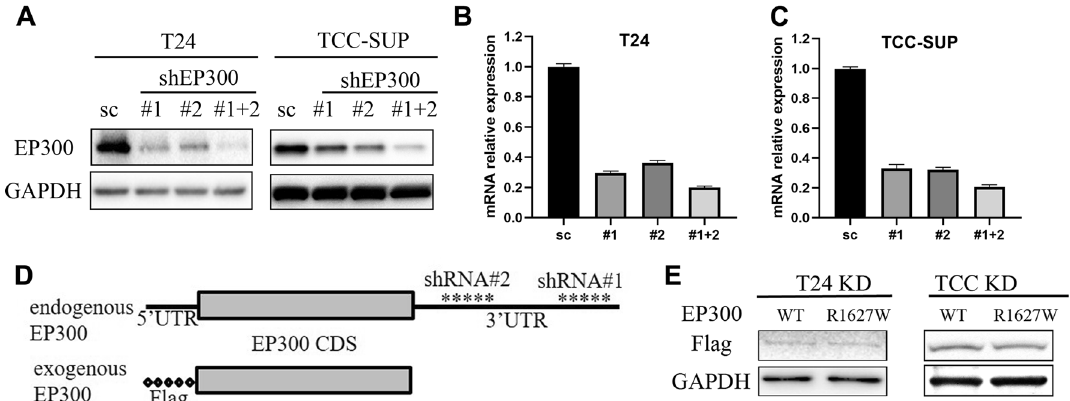
Fig. 2 Establishment of EP300 knockdown bladder cancer cell lines. A EP300 protein level in T24 and TCC-SUP cell lines after transfection of EP300 shRNAs. B, C EP300 mRNA expression level after knockdown of EP300 in T24 and TCC-SUP. D Diagrams of EP300 knockdown strategy. Two shRNAs